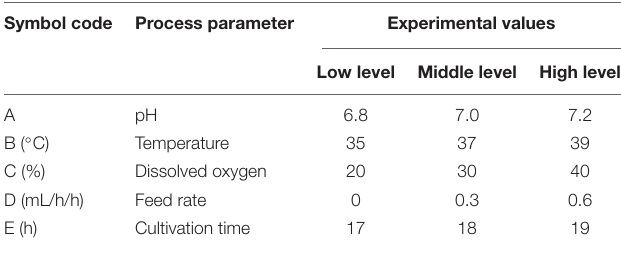
TABLE 1 | List of process parameters and their